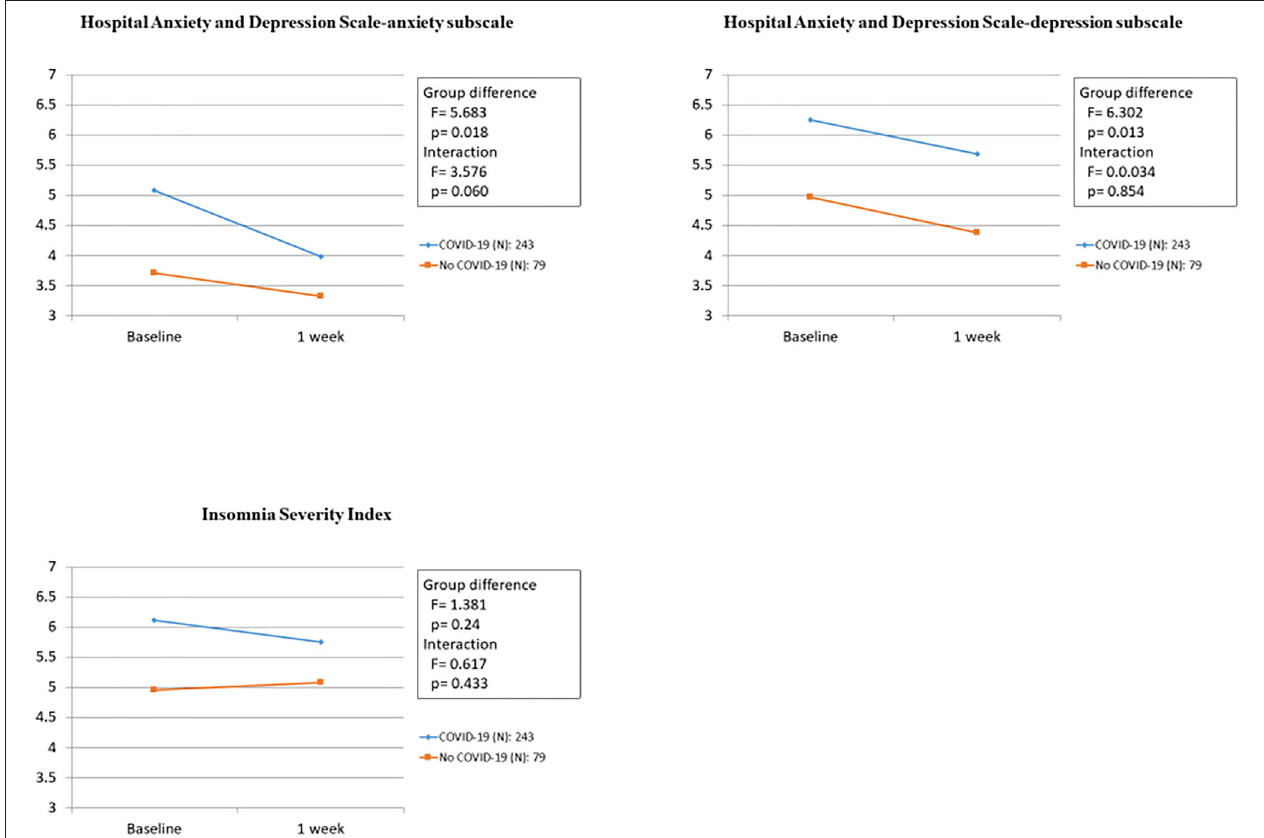
FIGURE 2 | Associations of anxiety, depression, insomnia and COVID-19 symptoms at 1 week.